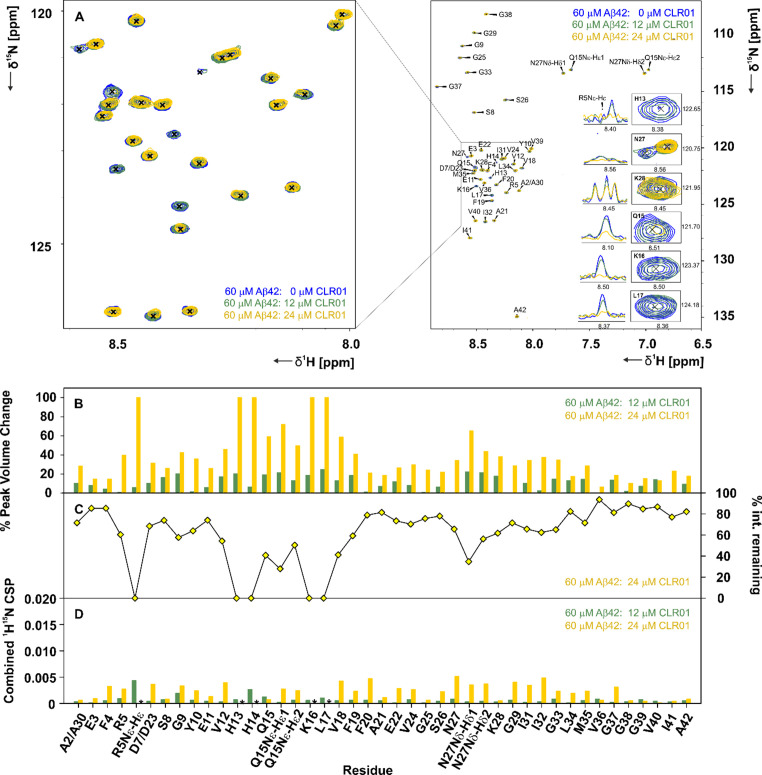
CLR01 interacts with Aβ42in specific areas.(A) A 2D-{1H, 15N}-HSQC overlay of 60 µM Aβ42 measured at 600 MHz and 278 K in the presence of 12 µM and 24 µM CLR01, depicted in green and yellow respectively. The spectra were recorded at 600 MHz and 278.5 K in 15 mM sodium phosphate, 55 mM NaCl, pH 7.2, 10% D2O. An external reference containing 0.3 mM DSS was used for calibration. Inset (A), enlarged on the left, depicts the 2D-{1H, 15N}-HSQC overlay focusing on the interacting region, including residues H13, Q15, K16, L17, N27, and K28, and the respective 1D-1H projections of a set of 2D-{1H, 15N}-HSQC peaks of Aβ42 after addition of 0 µL, 12 µL and 24 µL CLR01. (B) Illustrates the % peak volume change of residues of Aβ42 in the absence of CLR01, versus Aβ42 with 12 µM and 24 µM CLR01 respectively. (C) The % intensity remaining for 60 µM Aβ42: 24 µM CLR01 versus 60 µM Aβ42 plotted according to residue. (D) Spectral differences were mapped in the CSP chart according to the equation:CSP=((0.1·δ15Nref-0.1·δ15N)2+(δ1Href-δ1H)2)0.5. The combined chemical shift perturbation is shown for 60 µM Aβ42 alone versus 60 µM Aβ42: 12 µM and 24 µM CLR01 respectively. CSPs not depicted due to the disappearance of peaks are denoted by an asterisk.